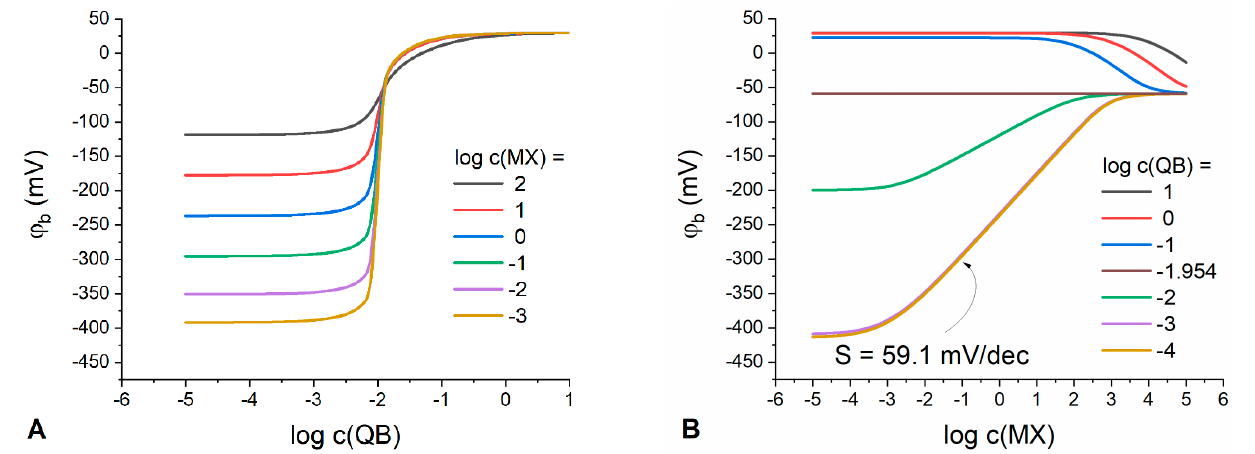
Figure 3. Phase boundary potential simulated: ( A ) vs. Q + B − concentration in the polymeric phase at different MX concentrations in the aqueous phase (indicated in the plot); ( B ) vs. MX concentration in the aqueous phase at different Q + B − concentration in the polymeric phase (indicated in the plot). c ( IR ) = 10 − 2 M; k M = 10 − 6 , k X = 10 − 4 ; k Q = 10 3 , k B = 10 2 ; k I = 10 − 5 , k R = 10 9